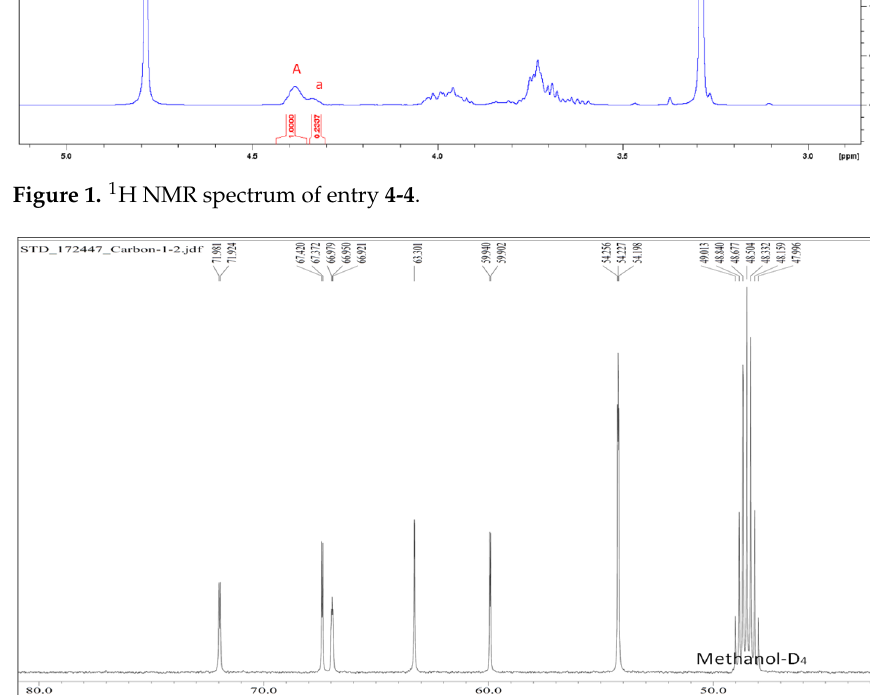
Figure 2. 13 C NMR spectrum of choline alfoscerate.